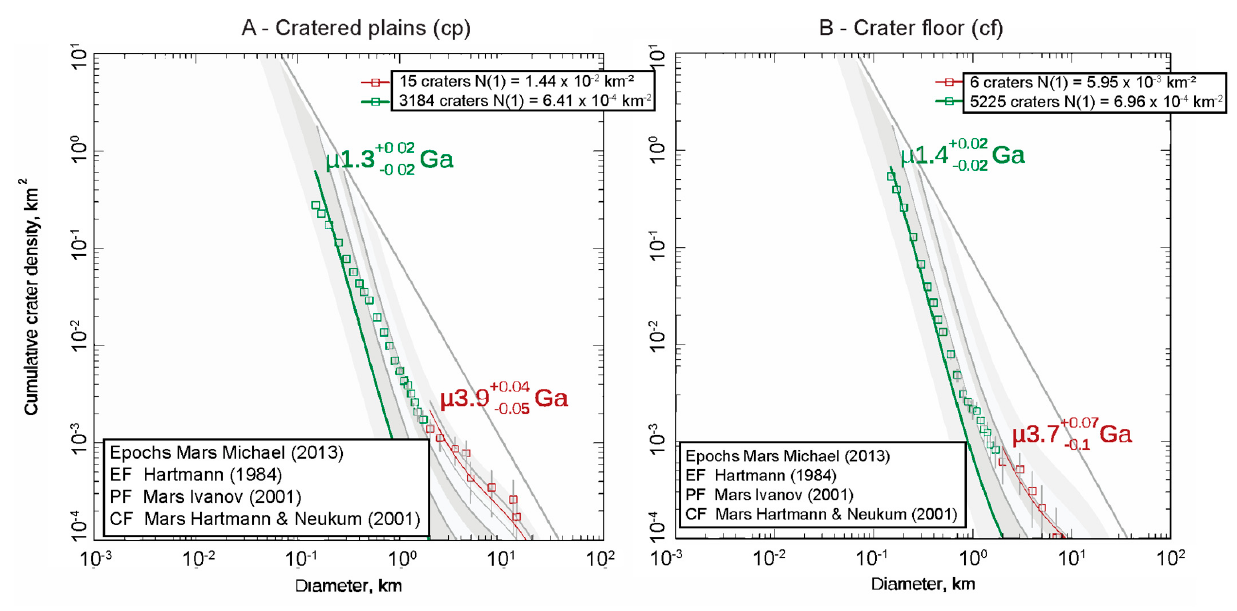
Figure 8. Surface age estimates using crater size frequency distributions. ( A ) Craters measured in the cratered plains (cp) unit are compared against standard isochrons. ( B ) Craters measured in the crater floor (cf) unit reflect a similar age to the cratered plains in ( A ). Both plots were generated using Craterstats open-source software using craters >100 m in diameter.